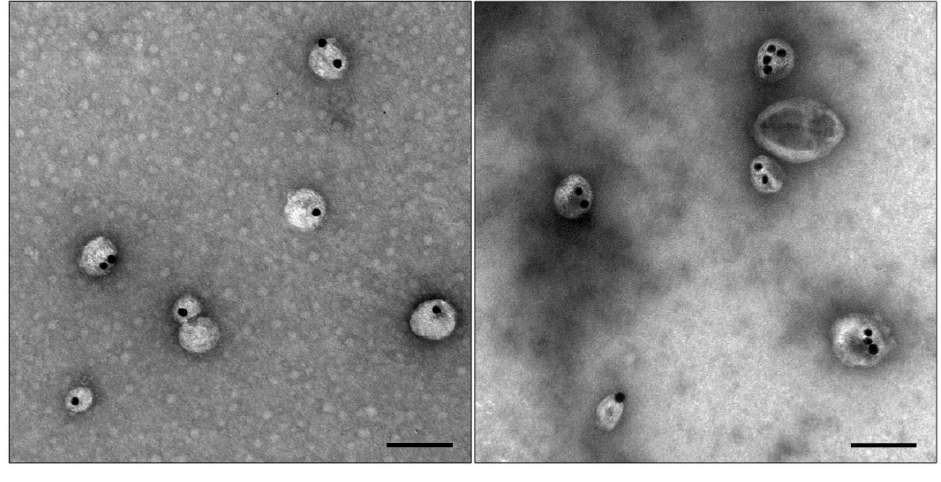
Figure 9. Ultrastructure of optimized MLNCs after 15 min fractionation in 58% sucrose and removal of excess sucrose. The scale bars correspond to 100 nm. Negative staining with a 0.5% uranyl acetate solution followed by TEM.